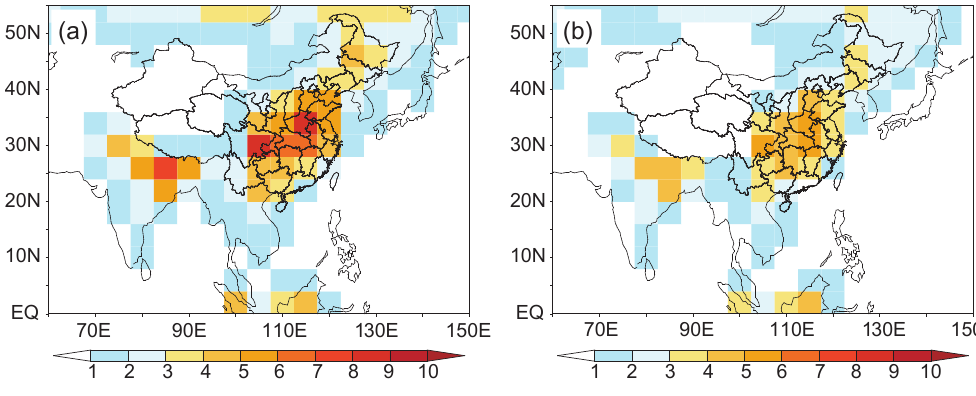
Fig. 1. Simulated summer (JJAS) mean OC concentrations at 1000hPa. (a) 1998; (b) 2002. Unit: µgm − 3 .